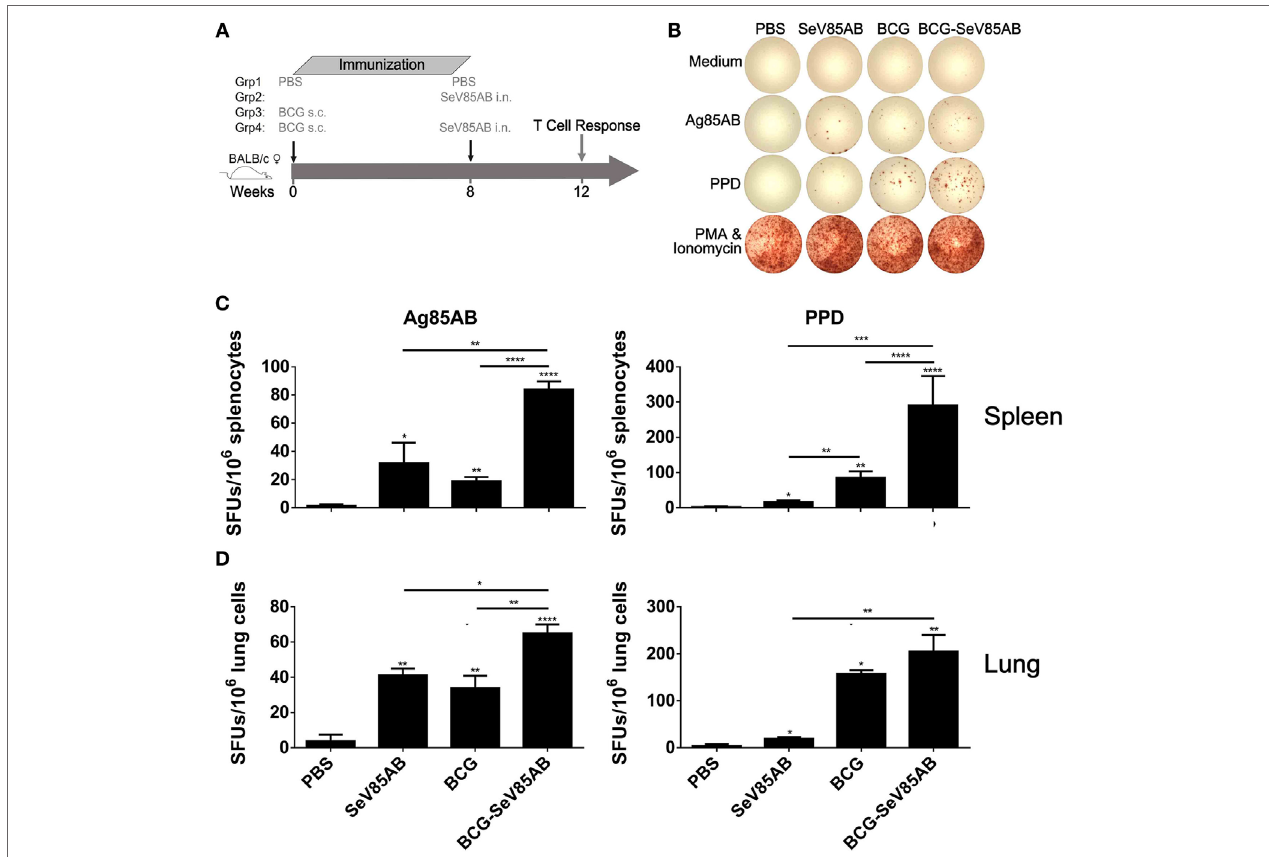
FigUre 1 | Boosting with SeV85AB increased the IFN- γ responses primed by bacille Calmette–Guérin (BCG) vaccination. (a) Immunization and detection schedule. Mice primed by BCG were i.n. boosted with SeV85AB or not, and 4 weeks later, they were sacrificed for assays of cellular immune responses. Controls received PBS, SeV85AB, or BCG only, at the indicated time points. (B–D) The IFN- γ responses determined by enzyme linked immunospot assay. Representative dot plots are shown in (B) . Cells from spleen (c) and lung (D) were stimulated for 20 h with Ag85AB peptide pool (5 µg/ml) or PPD (10 µg/ml) in 96-well plates and then the IFN- γ -secreting cells were detected and counted. PMA plus Ionomycin stimulation was used as positive control. Data are representative of two independent experiments with at least four mice per group. * P < 0.05, ** P < 0.01, *** P < 0.001, and **** P < 0.0001.